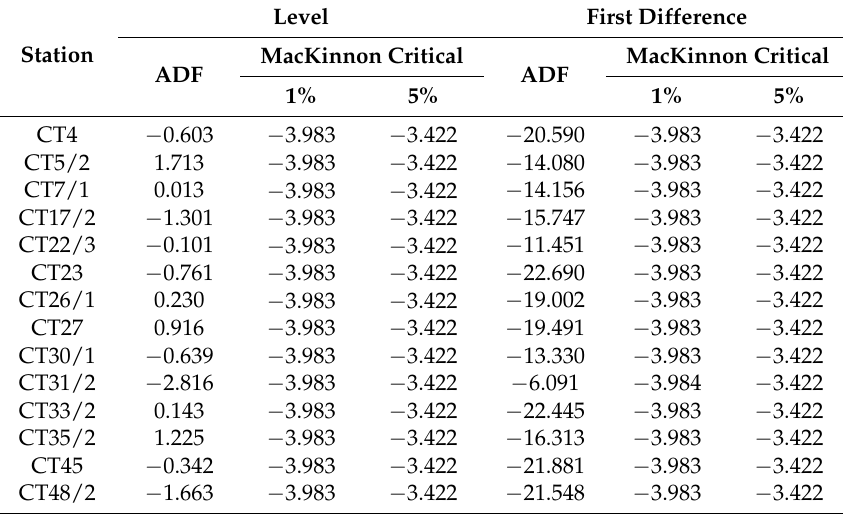
Table 4. Results of the unit root test.